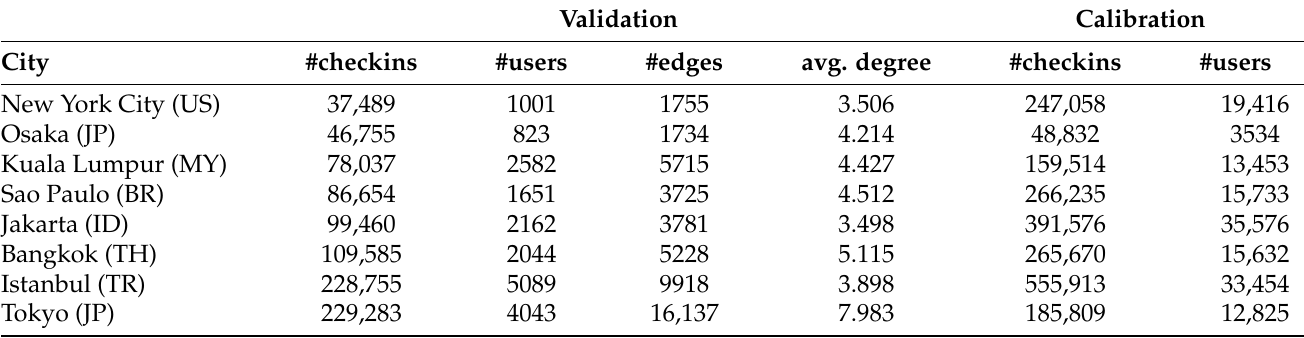
Table 3. A summary of the properties of the eight validation datasets and the corresponding contact graphs extracted from the public Foursquare dataset D and of the corresponding calibration FS